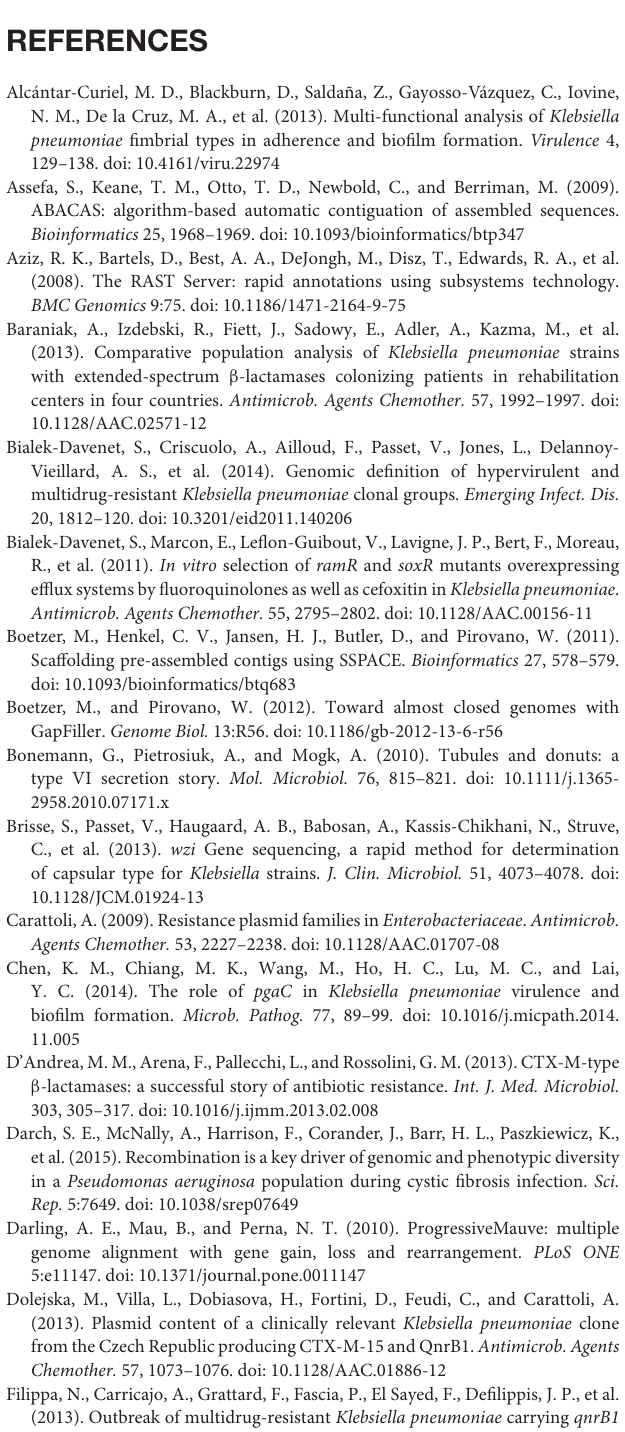
Figure S2 | Comparison of the T6SS loci identified in the outbreak clone and NTUH-K2044. The gradients (dark to pale) of the alignment region represent the percentage of sequence identity between samples defined by BLASTn. The